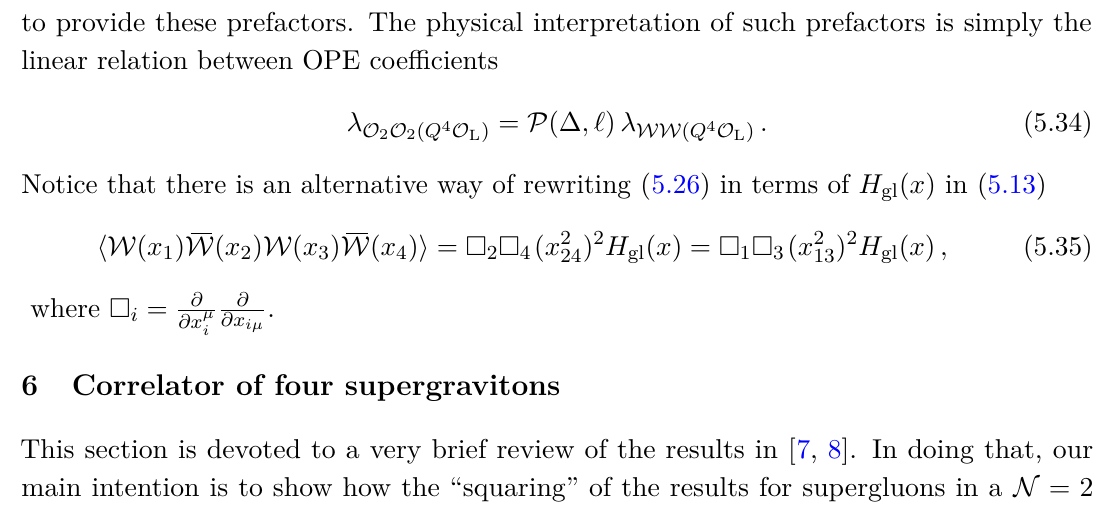
Figure 2 . The supergraviton multiplet. We are denoting the operators as [ ‘, stands for the Lorentz representation, ( p the conformal